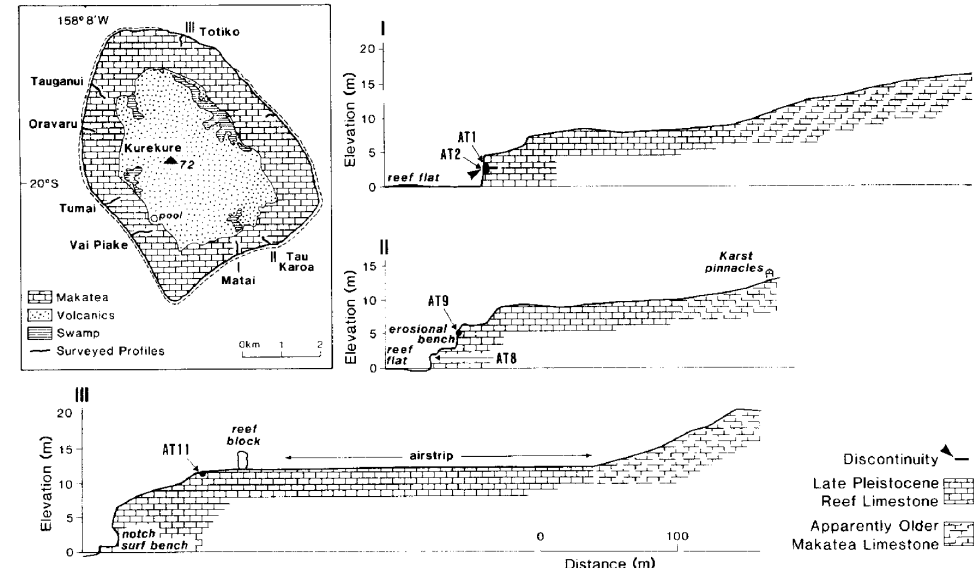
Figure 17. Sea-level indicators on Atiu, Cook Islands. Selected profiles and dated samples are shown (from Woodroffe et al., 1991).